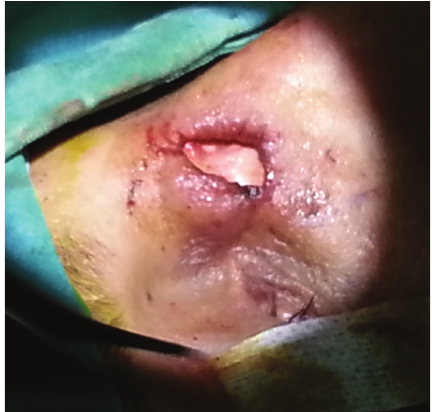
Figure 4: Reconstruction of the dorsal nasal defect with conchal cartilage after excision of the